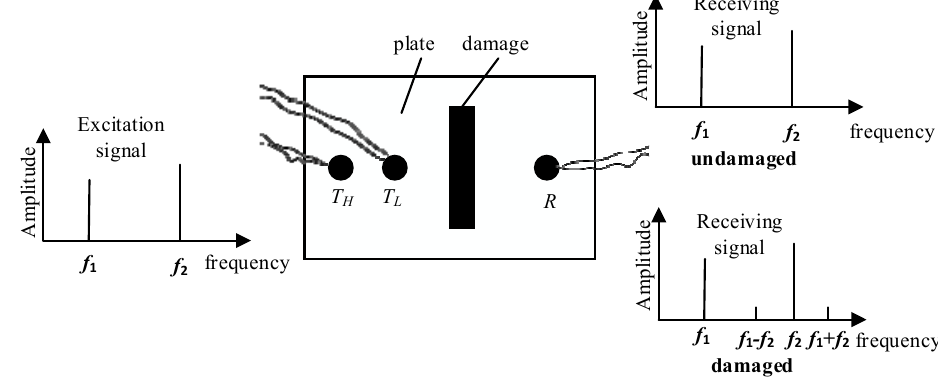
Figure 1. Schematic illustration of nonlinear modulation testing method.